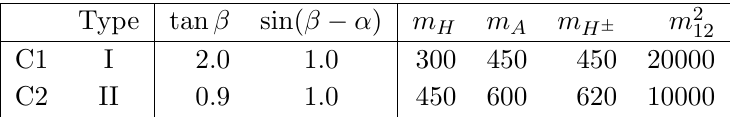
Table 2 . Parameter choices for the 2HDM benchmarks used in our study. All masses are given in GeV. The light Higgs mass is (cid:12)xed to m h = 125